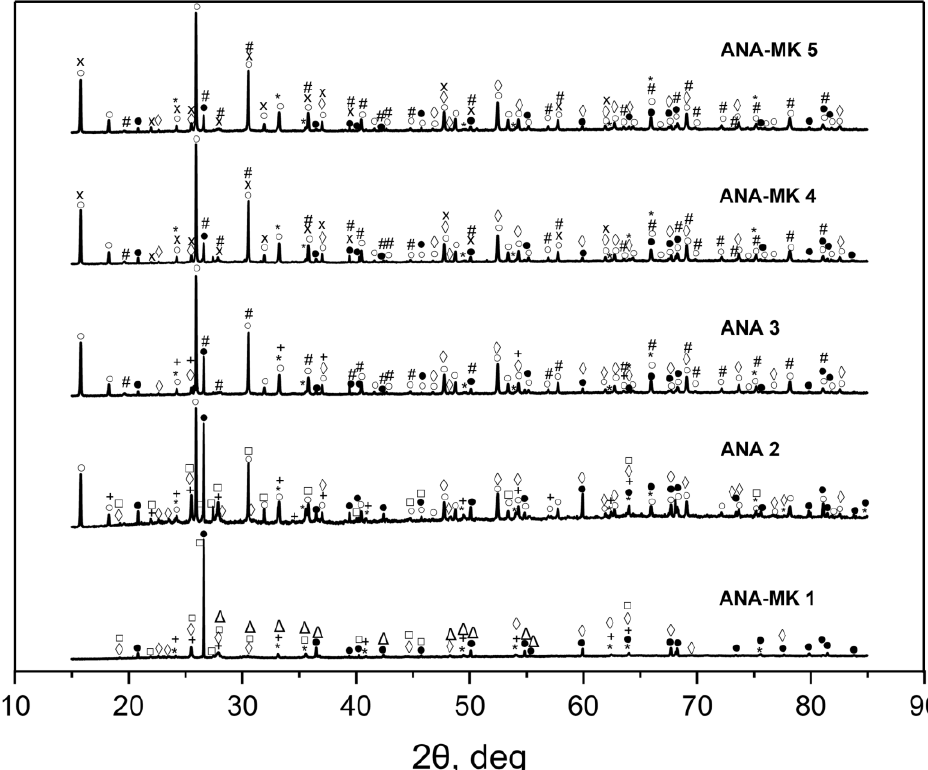
Figure 3. XRD patterns of the alkali-activated analcime sorbents. * Fe 2 O 3 (04-010-3230), • SiO 2 (04-014- 7568) □ CaAl 2 Si 2 O 8 (00-041- 1486), Δ NaAlSi 3 O 8 (01-083-1609), + CaMg 2 Fe 16 O 27 (00-056- 0629), ◊ LiAlSi 2 O 6 (04-020-3038), ○ NaAl(Si 2 O 6 )(H 2 O) (01-074-2219), # Mg(SiO 3 ) (01-076-6770), X K 0.05 Na 0.94 Ca 0.01 Al 1.01 Si 2.99 O 8 (04-023-4722).